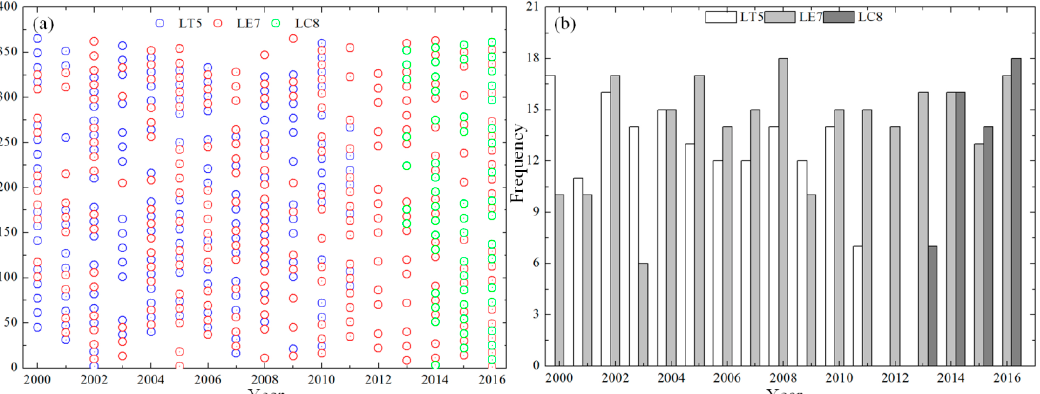
Figure 3. All available Landsat images with cloud coverage less than 70% from 2000 to 2016, where the LT5, LE7, and LC8 represent the Landsat 5 TM, the Landsat 7’s ETM+ sensor, and the Landsat 8 OLI sensor, respectively. ( a ) Day of year (DOY) distribution of Landsat images, and ( b ) quantity statistics of Landsat images in every year.